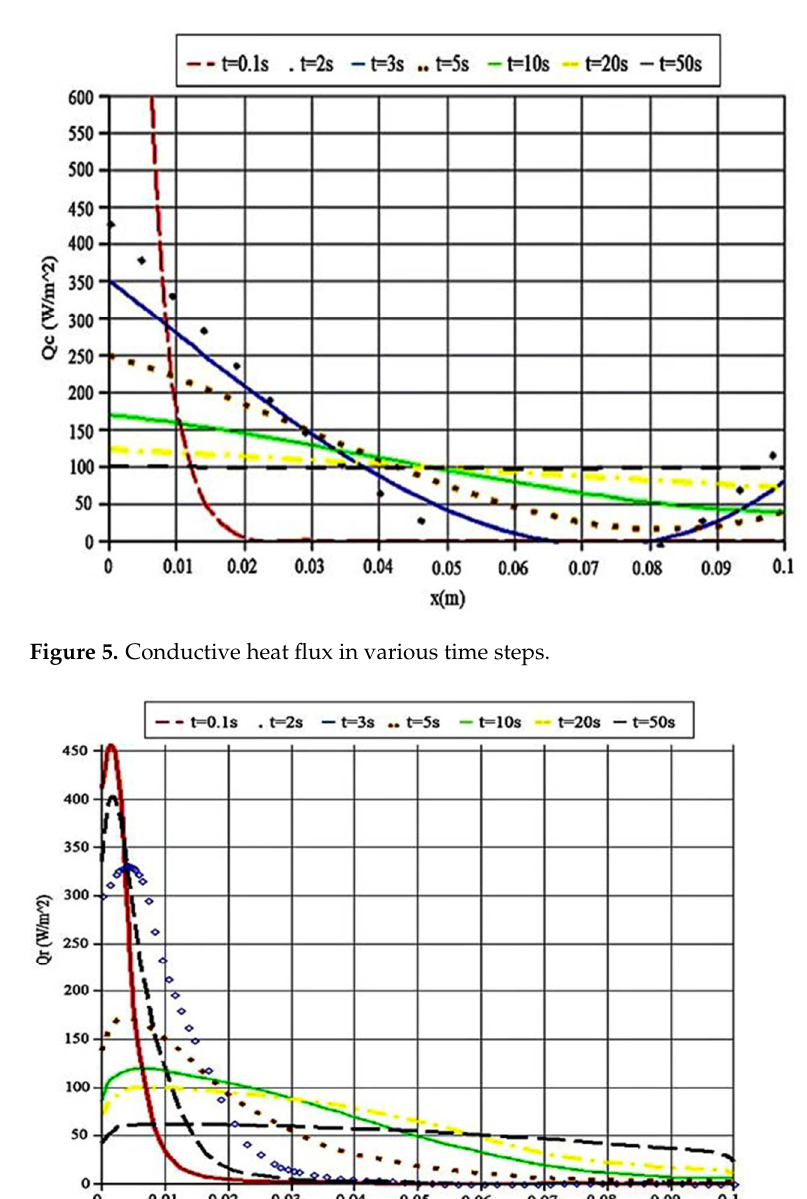
Figure 6. Radiative heat flux in various time steps.